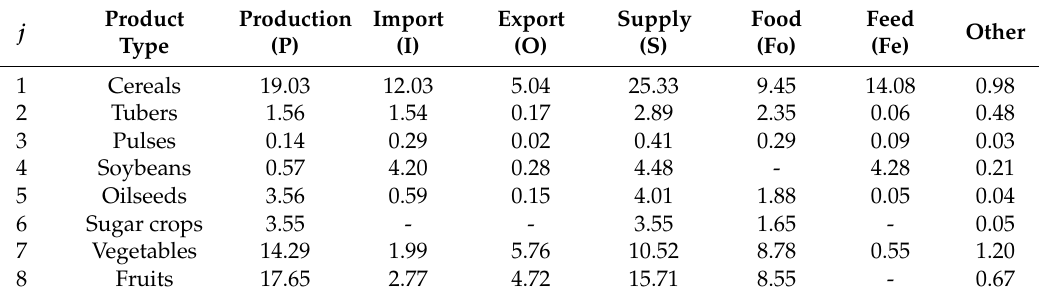
Table 1. Mass balance of the Italian food supply chain (FSC) (in